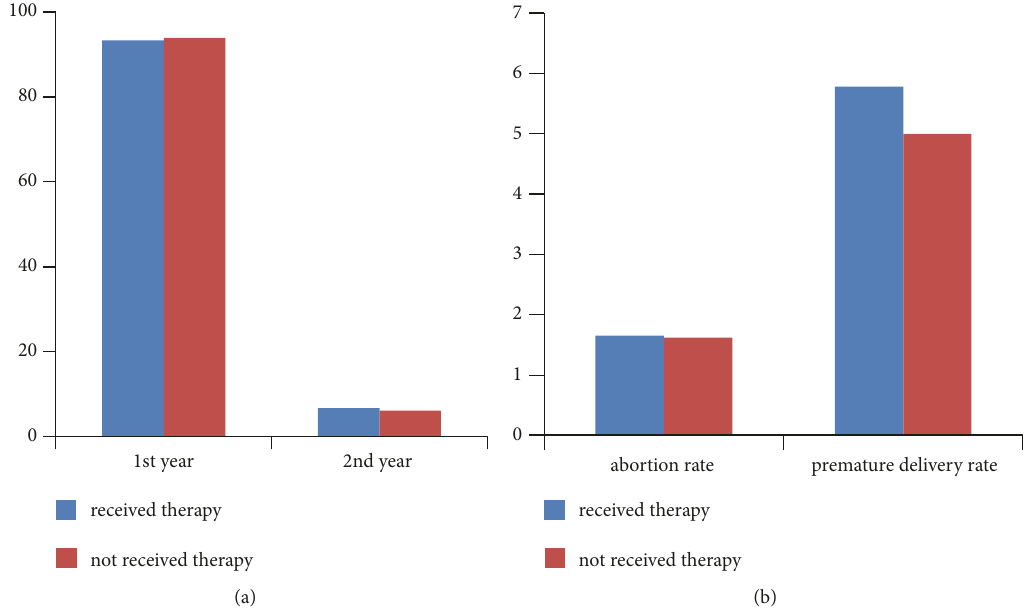
Figure 3: Effect of antiviral therapy on male fertility and birth defects. (a) Impregnation ability and (b) abortion and premature delivery rates in the two groups of